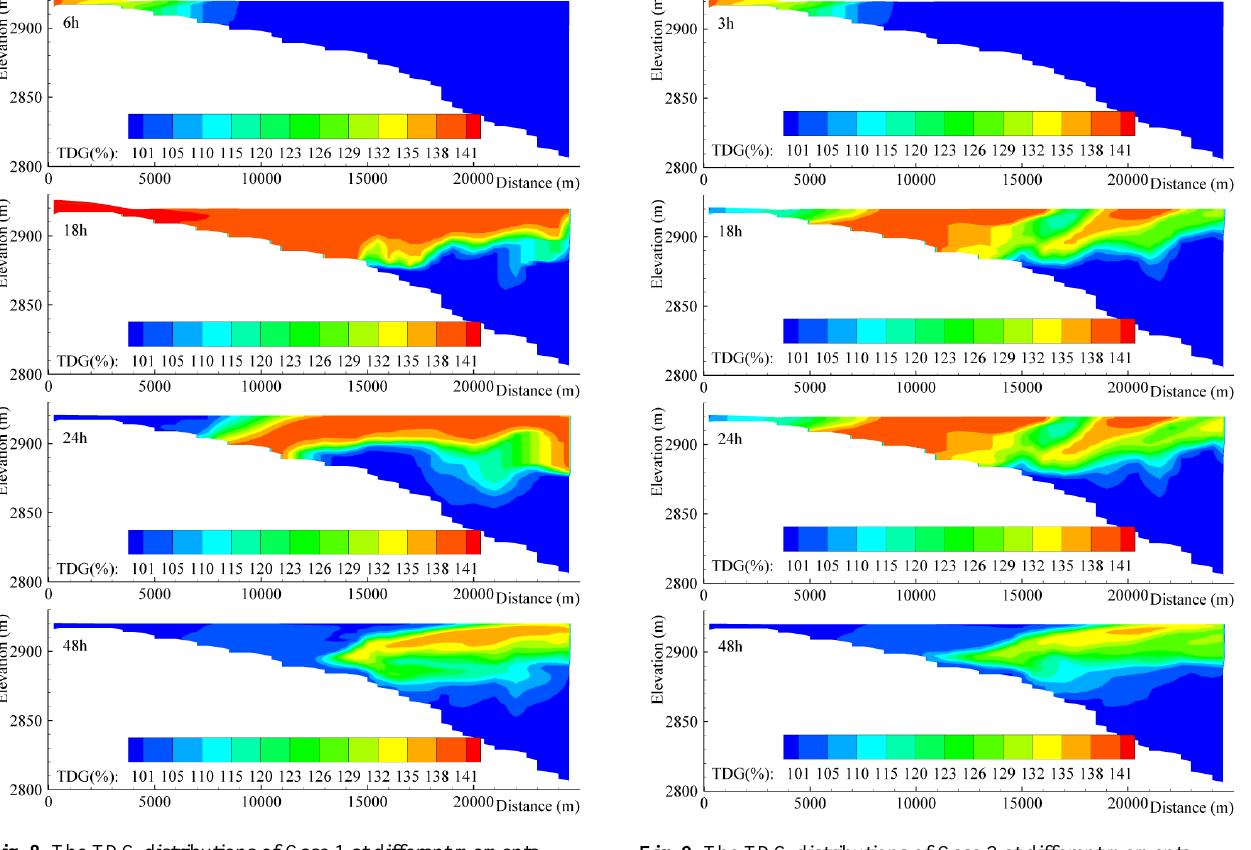
Fig. 8. The TDG distributions of Case 1 at different moments. Fig. 9. The TDG distributions of Case 2 at different